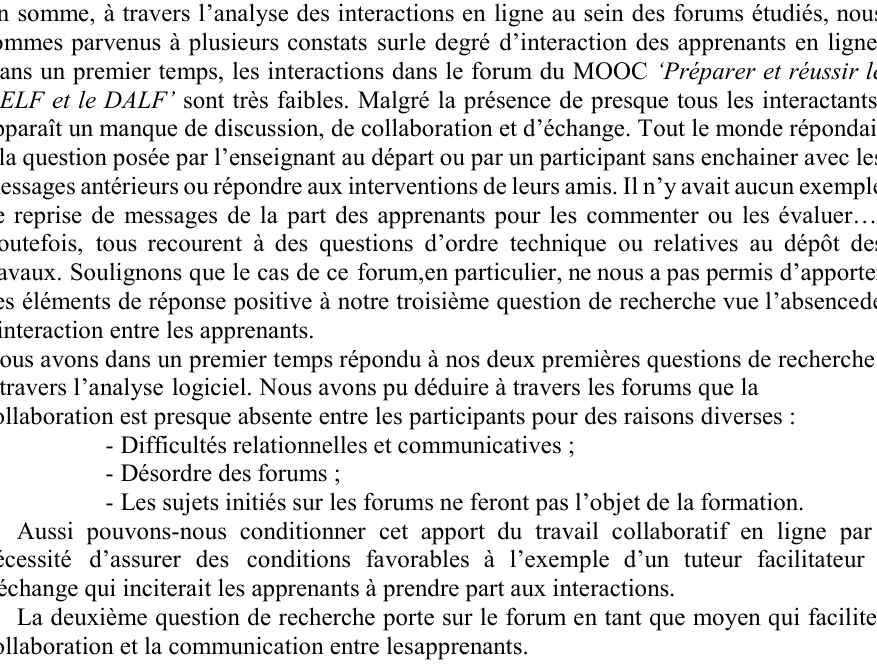
Fig. 5. Les formules de fermeture de conversation sur les forums étudiés des trois